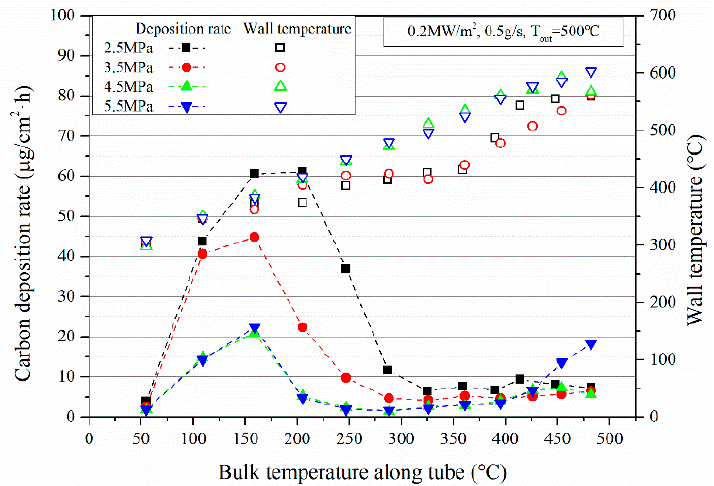
Figure 9. Temperature and deposition rate profiles at heat flux of 0.2 MW/m 2 .